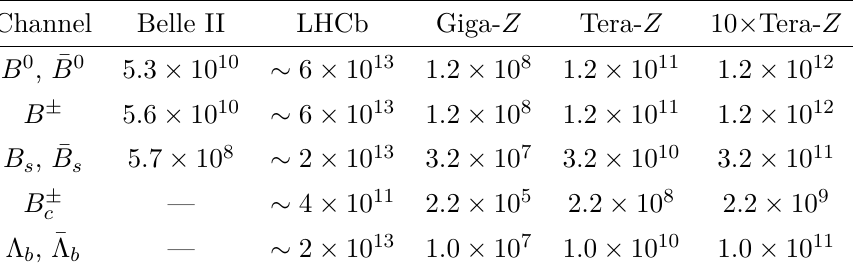
Table 2 . Number of b hadrons expected to be produced in Belle II, LHCb and the future Z factories. We assume Belle II to run at Υ(4 S ) mode with an integrated luminosity of 50 ab − 1 and at Υ(5 S ) with 5 ab − 1 , and estimate the LHCb productions following the b ¯ b acceptance in [17]. The production fractions for B 0 / ¯ B 0 , B ± , B for B ± mesons, we use their production rate at the Z pole presented in [18] for calculation, with B ∗ c decays being included, while their production rate at LHCb is taken from a recent measurement [19]. Note, Belle II will have no statistics on the B ± energy threshold.